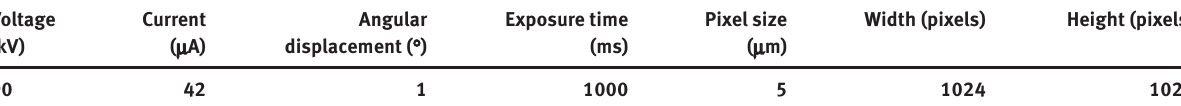
Table 2: CT parameters used for the needle carbon-fiber-reinforced ceramic composite.